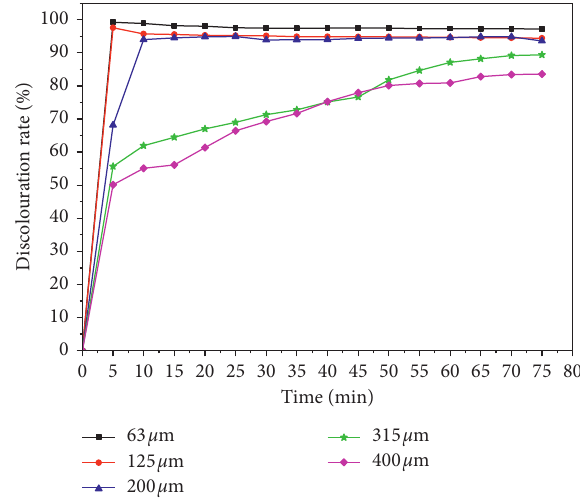
Figure 6: Effect of sand grain size on the discolouration